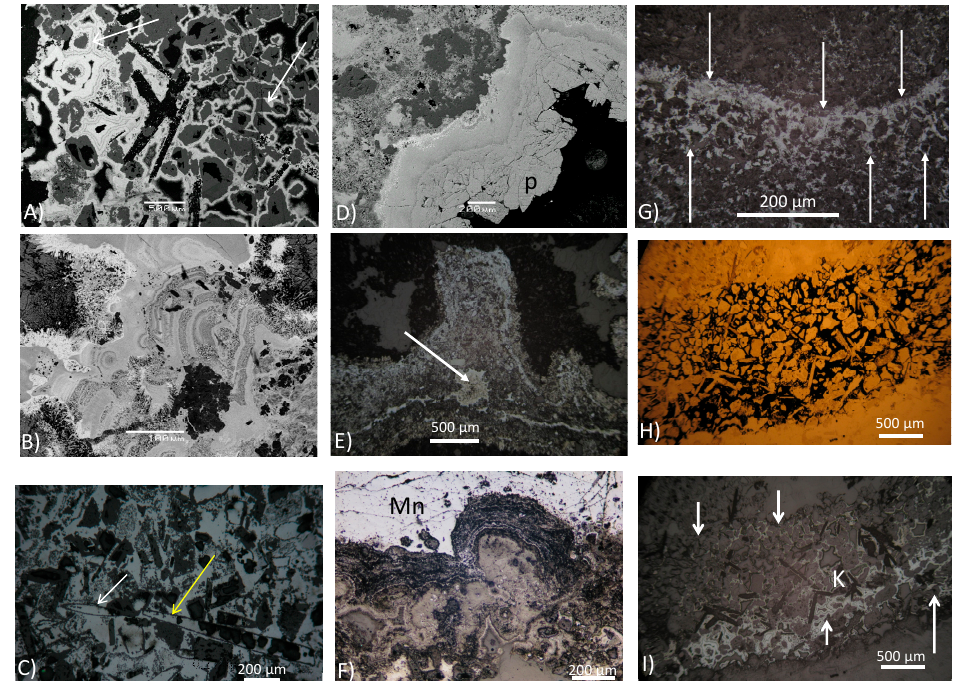
Figure 3. Scanning electron microscope (SEM) backscatter electron images ( A , B , D , E , F ) and reflected light photomicrographs( C , G , H , I ) of Mn-oxide microtextures ( A ) Highly mineralized MnMISS layer with Mn oxide cement-supported texture (left side) grading into grain supported mineralized layer having minor Mn-oxide cement (right side). White arrows for Mn cement. ( B ) Colloform layering of Mn oxide cement. ( C ) Mn oxide cemented MnMISS, reflected light; possible diatoms/algae (white arrows) and possible sponge spicules (yellow arrow) are partially to completely coated by microcrystalline Mn-oxides, the other detritus are K-feldspar and/or unaltered glass fragments with Mn coatings. ( D ) Very fine wavy layers of microcrystalline Mn-oxide lining walls of void space, overgrown by planar layer of massive crystalline pyrolusite ( p ). ( E ) Single tufted microstructures characterized by asymmetric orthogonal to domal thickening of Mn oxide-matrix supported lamina. Note that these microstructures are linked by thin continuous non-isopachous Mn laminae. Note microcrystalline Mn oxide-filled void in the central part (white arrow plus encircled). ( F ) Pseudocolumnar microstromatolite-like structures with microcrystalline (pale) and amorphous cryptocrystalline (dark) Mn oxide laminae, which overgrow bulbous Mn oxides ( B ); K: framework grains. Microstromatolites are overlain by anhedral microrystalline Mn oxide (Mn). ( G , H , I ) Photomicrograph in reflected light ( G and I ) and transmitted light ( H ) of bedding parallel Mn-oxide cement supported laminated texture; the white arrows point to the margins of the lamina.